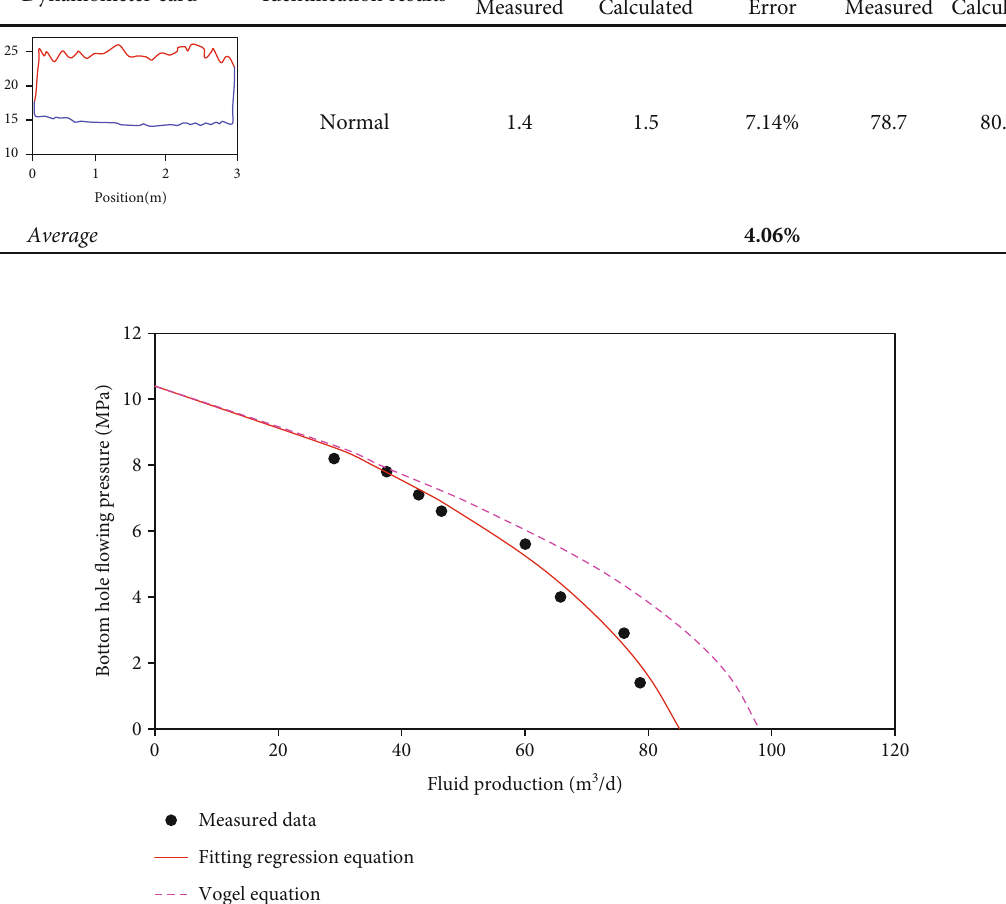
Figure 4: In fl ow performance relationship